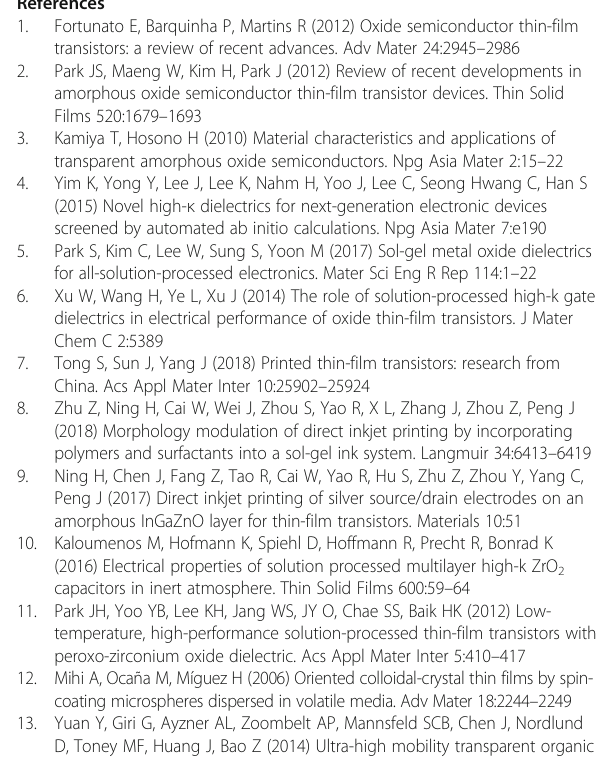
Additional file 1: Figure S1. Images of contact angle of oxide precursor on ITO substrate for different ozone UV treatment period: (a) 20s, (b) 40s, and (c) 60s and polarizing microscope of annealed ZrO 2 film on ITO substrate for different UV treatment period (d) 20s, (e) 40s, and